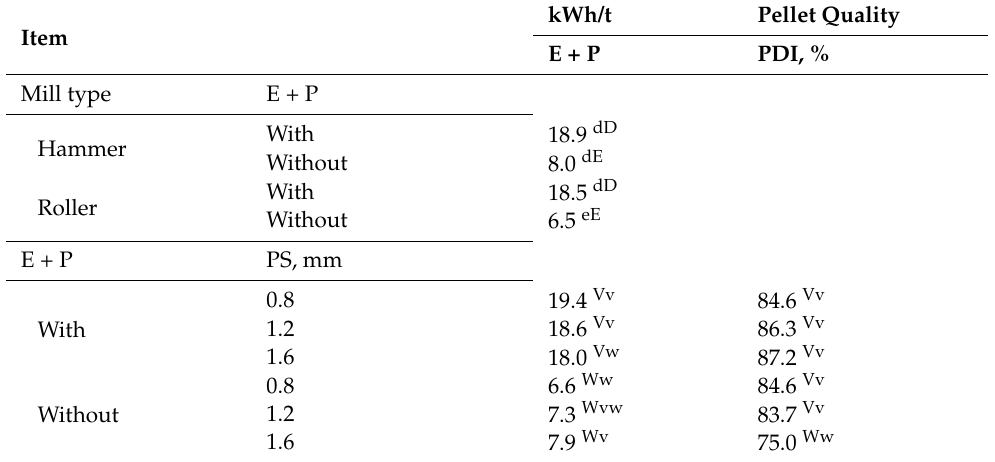
Table 4. Breakdown of significant interactions as presented in Table 3.